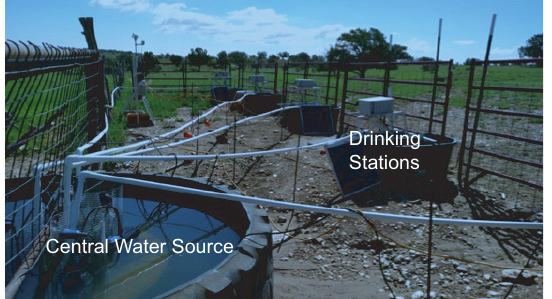
Figure 6. System setup at a remote testing site with drinking stations and a central water source.